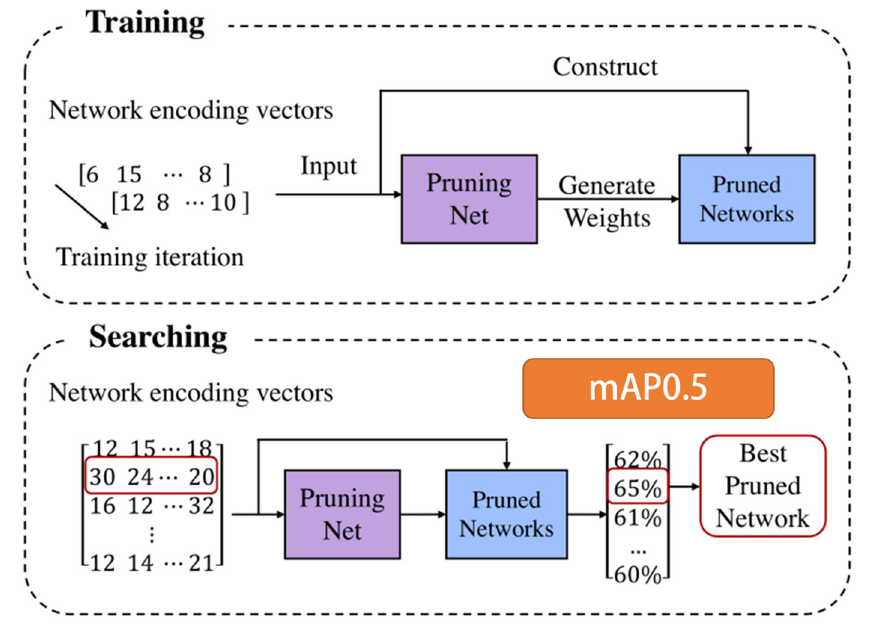
Figure 7. The process of the meta channel pruning method (MCP). At each iteration, a network encoding vector is randomly generated. The Pruned Network is constructed accordingly. The PruningNet takes the network encoding vector as input and generates the weights for the Pruned Network. Searching for the best Pruned Network. We construct many Pruned Networks by varying network encoding vector and evaluate their goodness on the validation data with the weights predicted by the PruningNet. No finetuning or re-training is needed